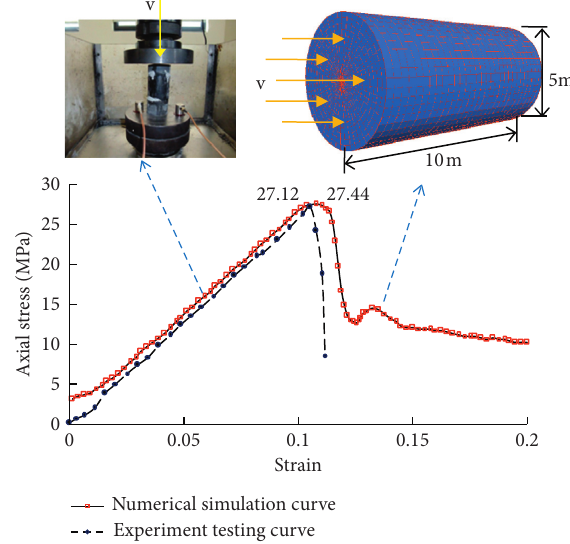
perimental test.